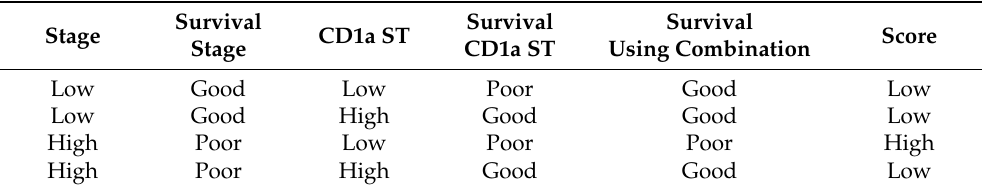
Table 6. Description of the prognostic performance of a score combining the staging and CD1a infiltration in OPSCC patients.